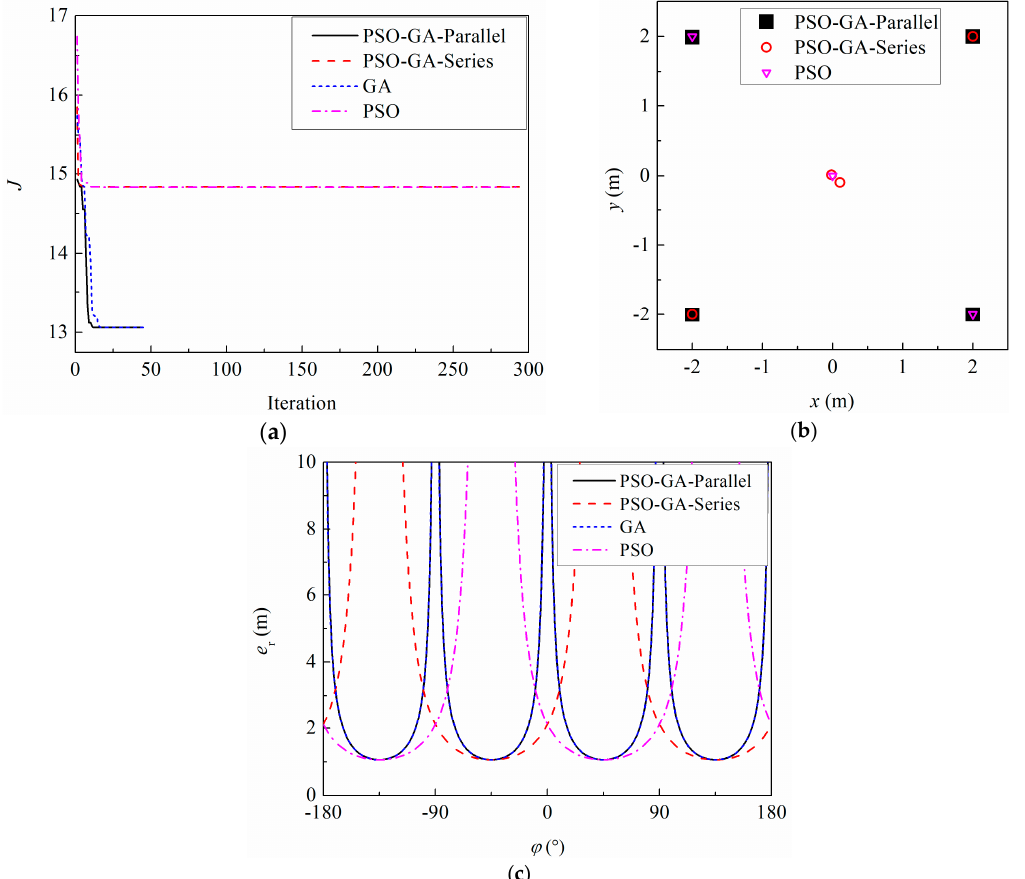
Figure 5. Optimization results by using different algorithms: ( a ) evolution curve; ( b ) array deployment; ( c ) Cramér-Rao lower bound (CRLB) curve.